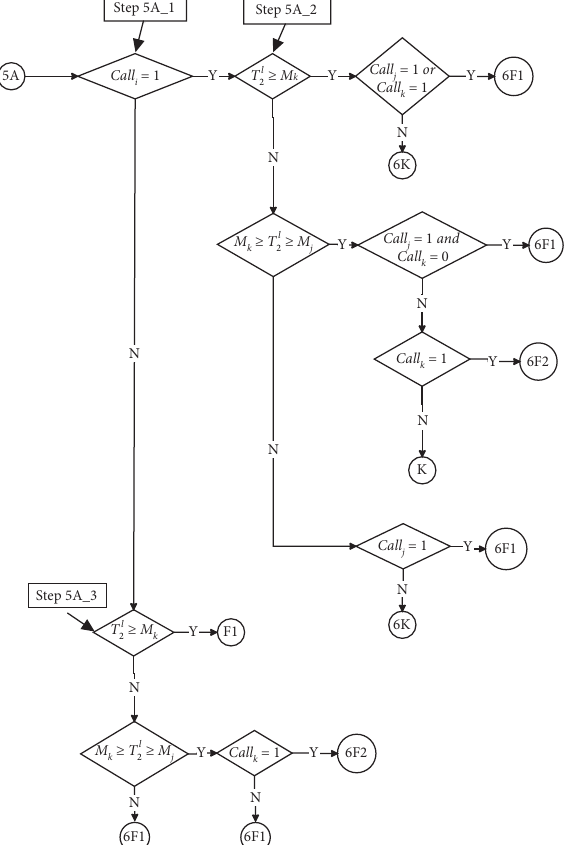
Figure 2: Steps of the TPS_DT algorithm Part 5A shown in Figure